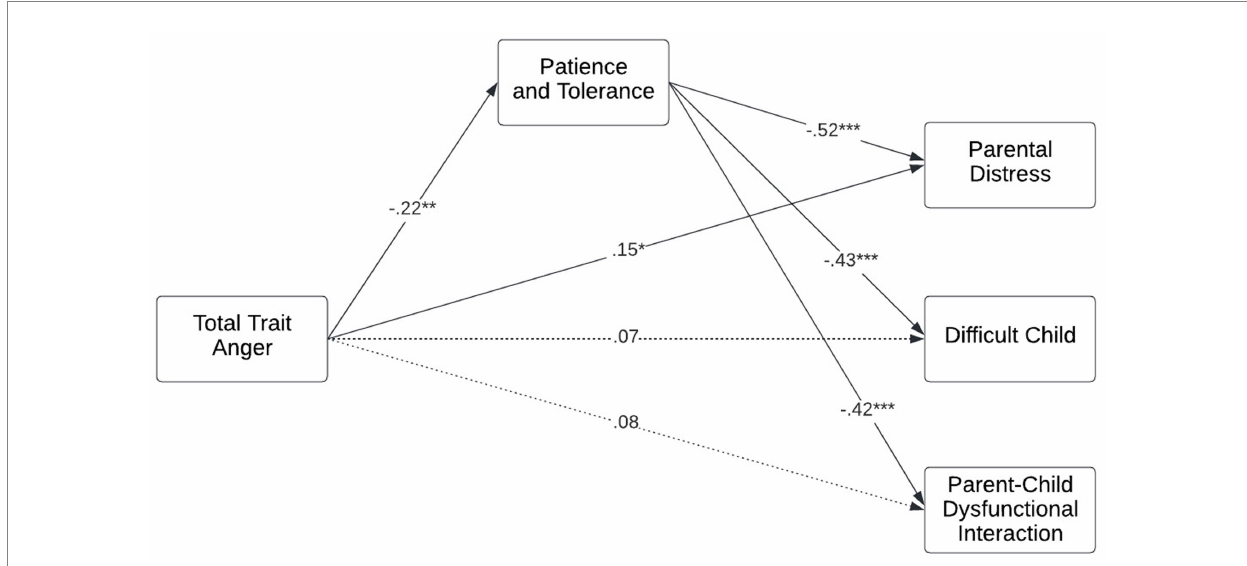
FIGURE 1 Father trait anger on parenting stress in the toddler years, through patience and tolerance in the father–infant bond. All effects are standardized. Model adjusted for covariates. n = 177 fathers of 205 children. Cluster robust standard error estimators were used to account for the clustered nature of the data, i.e., fathers with multiple children. Dotted line indicates non-significant paths. * p < 0.05, ** p < 0.01, *** p <